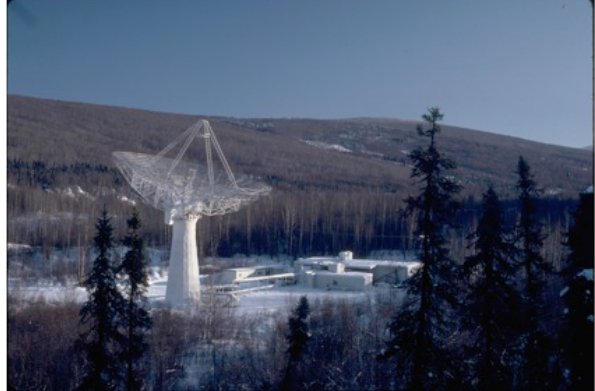
Figure 3. The Chatanika ISR, November 1981. Photo by C. Hein-